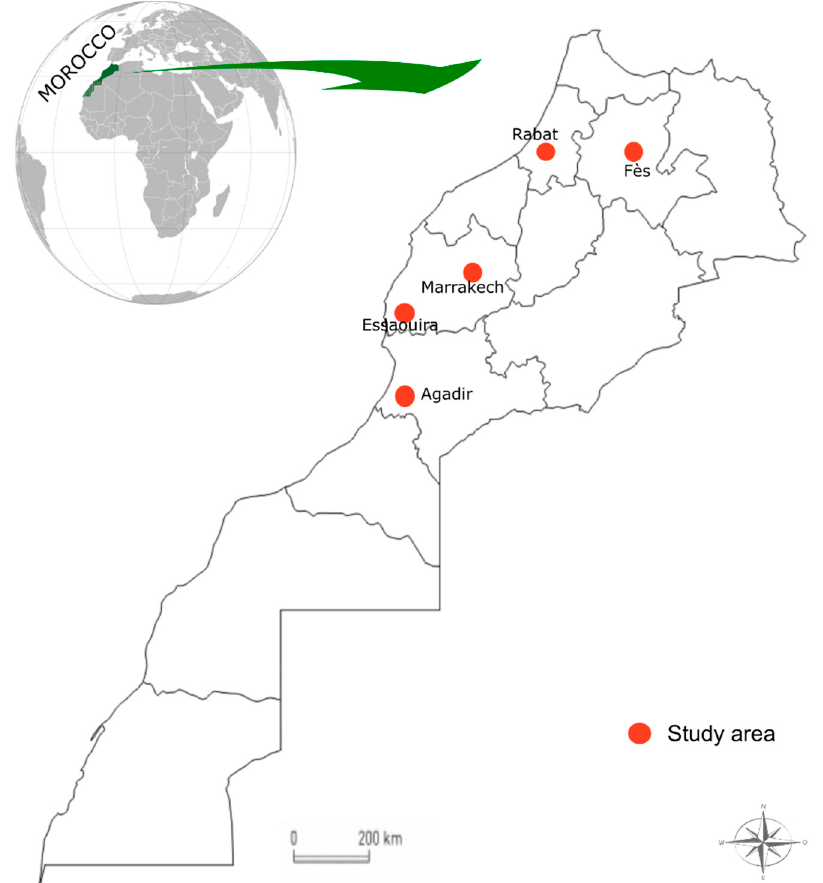
Figure 1. Study area.